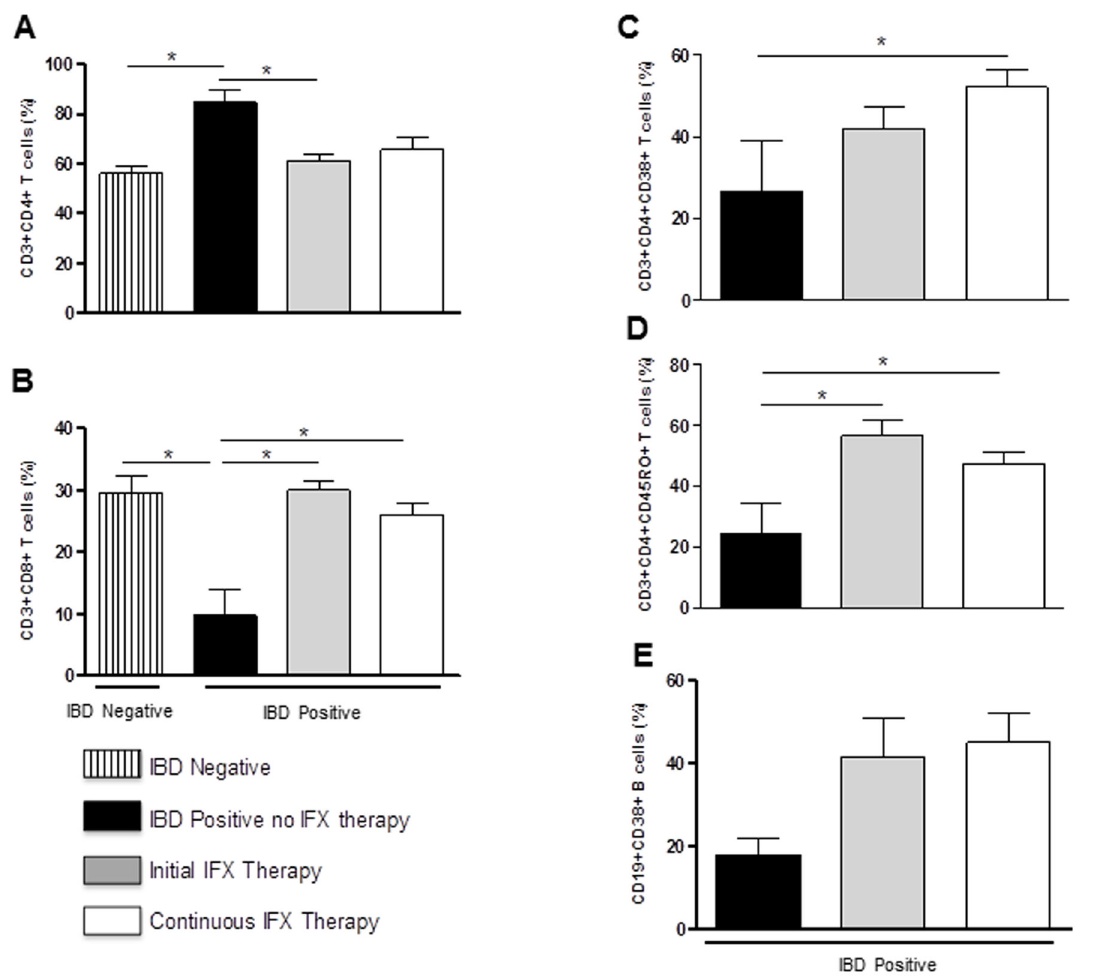
Figure 1. Effect of IFX on lymphocyte counts and cell activation. Flow cytometric analysis of peripheral blood samples from IBD patients with or without IFX therapy. A-E summarize the immunophenotypes (CD4+, CD8+, CD4+CD38+, CD4+CD45RO+, CD19+CD38+, respectively). Values are expressed as mean ± SEM of percentage of cell percentages. (A) A significant increase in IBD patients in CD4+ T cells compared to IBD negative healthy controls with a significant decrease in patients initiating IFX therapy was observed. (B) A significant increase in CD8+ T cells was observed in patients initiating IFX therapy as well as those on continuous IFX therapy compared to non-treated IBD patients. Patients on continuous IFX therapy also had increased levels of activated CD4+CD38+ T cells (C), CD4+ CD45RO+ T cells (D) and activated CD19+ CD38+ B cells (E) as compared to patients